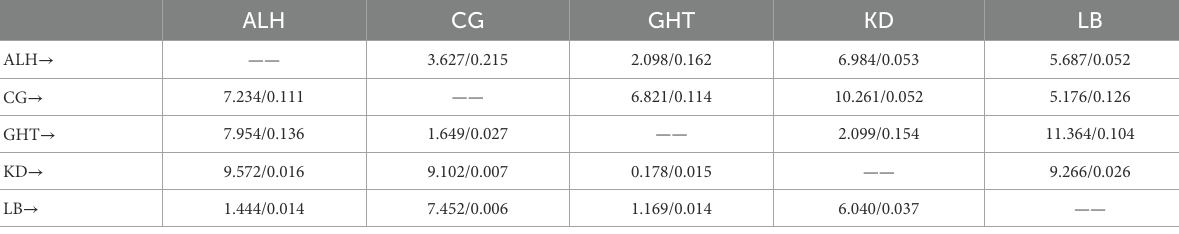
The left and right values of “/” represent the historical gene flow ( N m ) estimated by Migrate-n and the contemporary migration rate estimated by BayesAss, respectively. The value ( N m ) is calculated by the